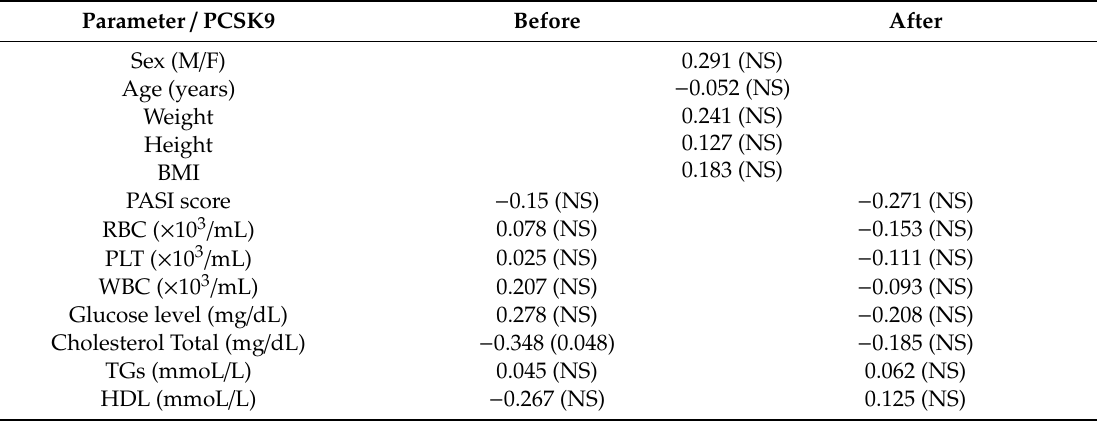
Table 3. Variables of the study in patients before and after treatment and correlations with PCSK9 levels. Bold values mean statistically significant results.